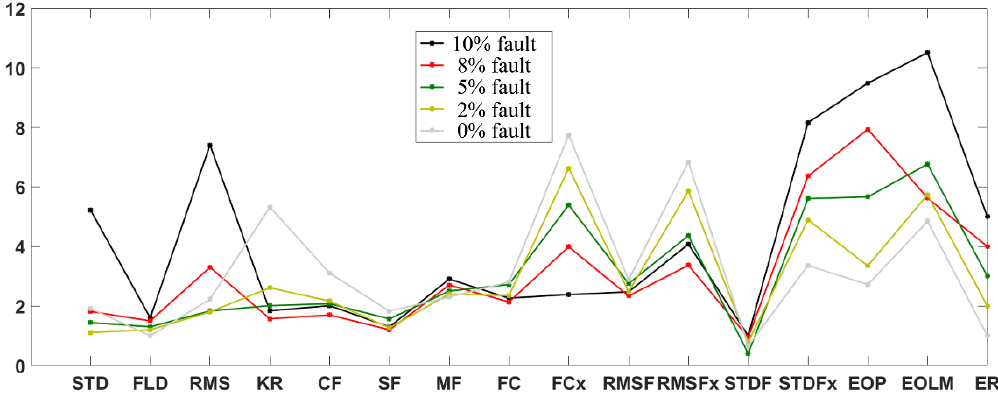
Figure 8. Feature comparison of the tracking error signal for weak fault severity.